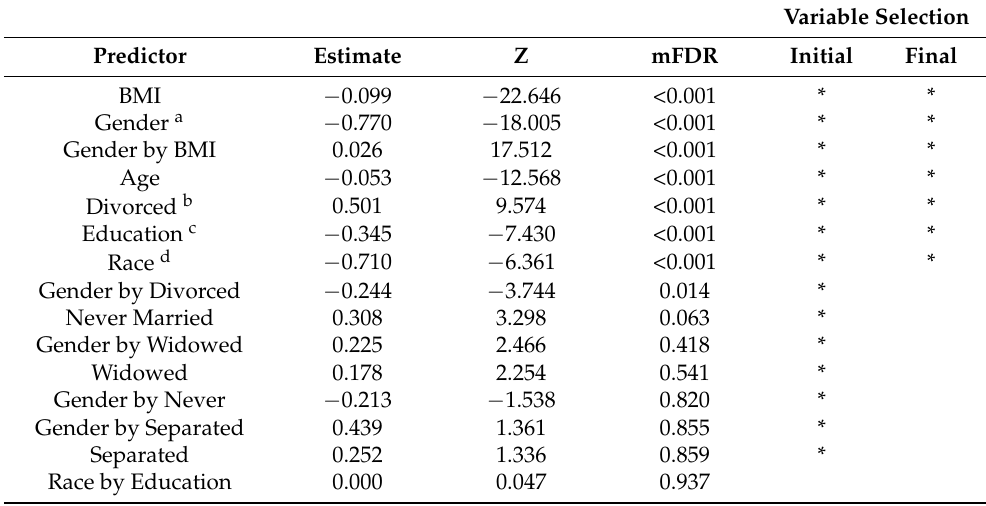
Table 2. Results of the penalized logistic regression. Log odds ratios, z-values, and marginal false discovery rate (mFDR). The predictors selected for the final model are indicated by asterisks in the last column.